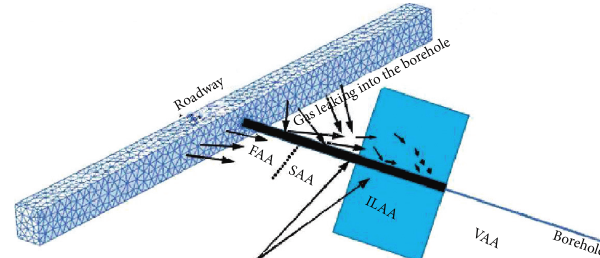
Figure 3: Distribution of air leakage areas around the